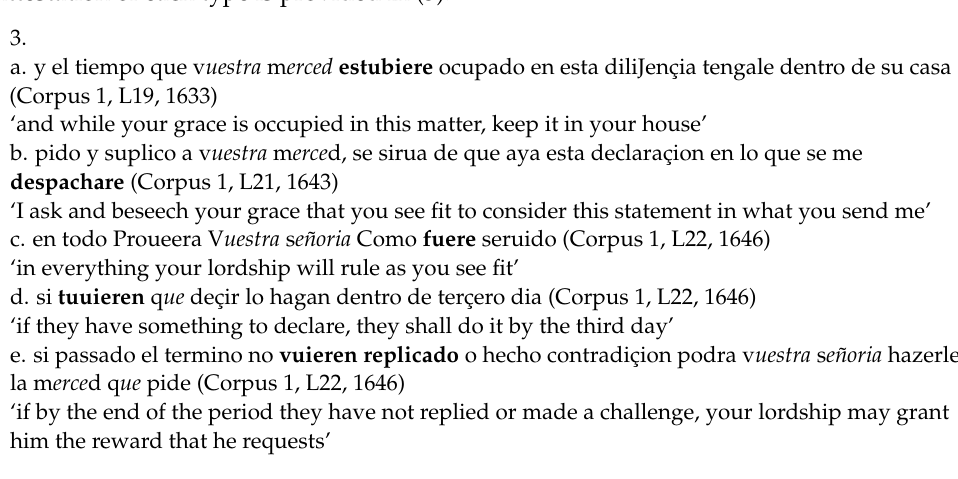
Table 1. Future subjunctive in Corpus 1 by structure and time period.